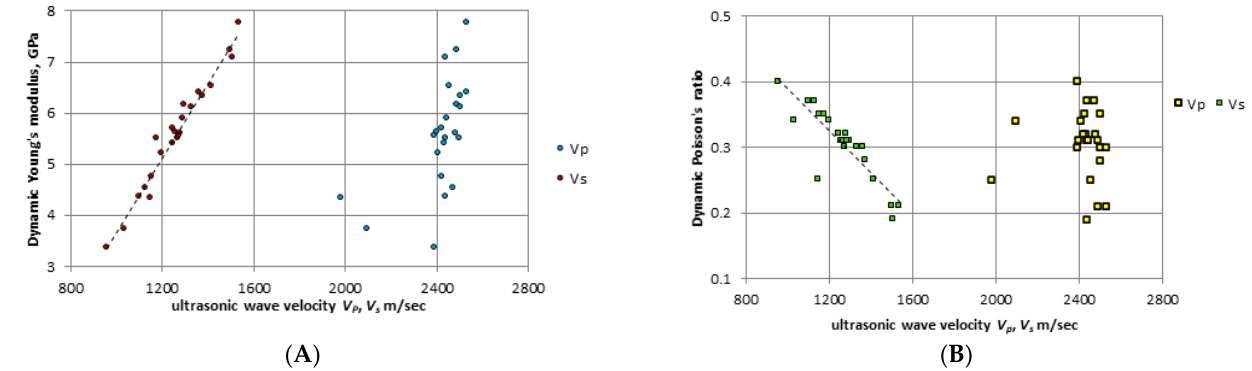
Figure 9. Linear dependences for the tested coals: ( A ) E dyn = f ( V S ); ( B ) ν dyn = f ( V S ). Table 10. Linear regression analysis results of E dyn = f ( V S , V P /V S ) and ν dyn = f(V S , V P /V S ). Relationship R 2 Coefficient Relationship